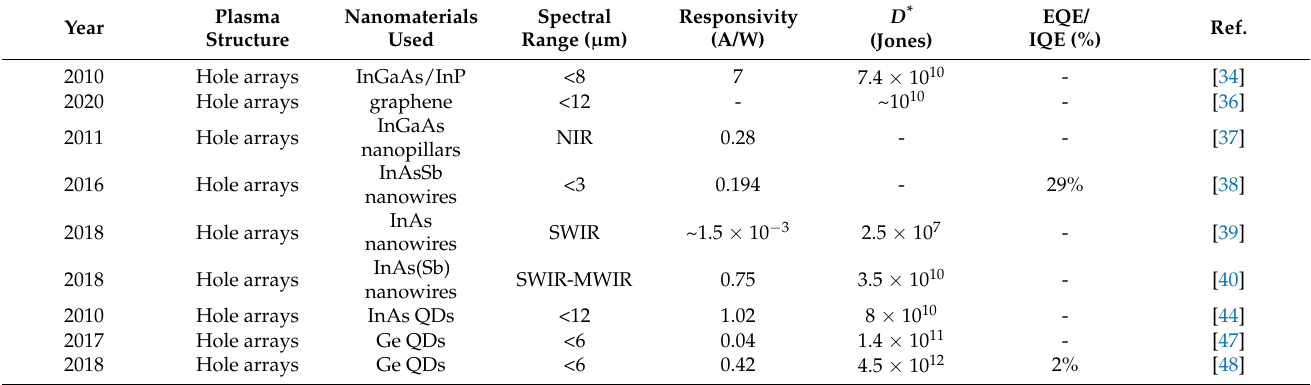
Table 1. Progress in plasmonic enhanced nanocrystal infrared